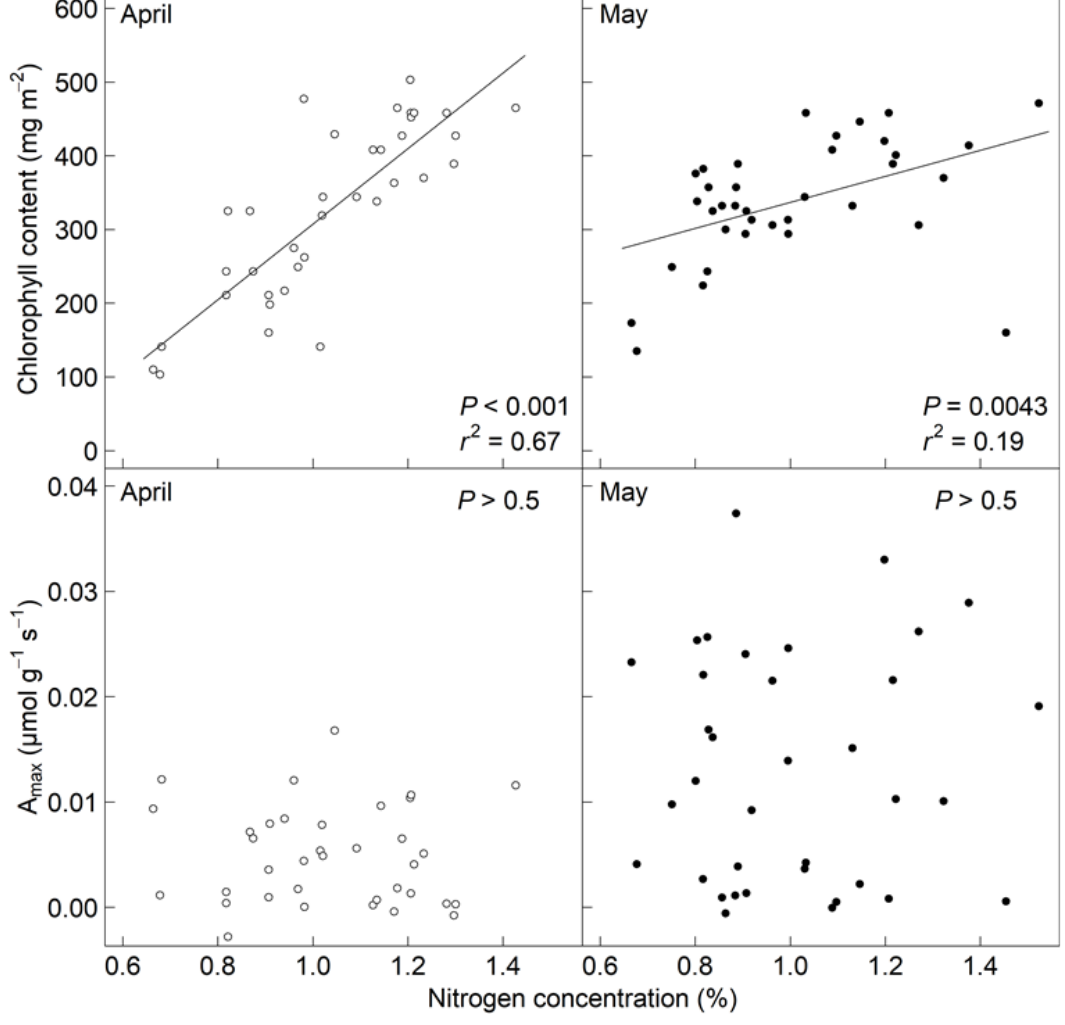
Figure 4. Relationships between chlorophyll content and nitrogen concentration, and between photosynthetic capacity and nitrogen concentration in Pinus rotundata in April and May